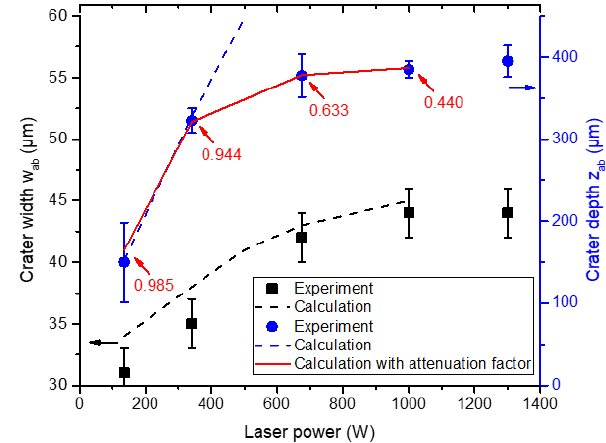
Fig. 4. Experimental crater depth z ab (blue dots) and diameter w ab (black dots) as a function of laser power. The black and blue dashed lines are the corresponding numerical results. The red line indicates the depths obtained with the model considering the attenuation factors (the numerical values are indicated for each